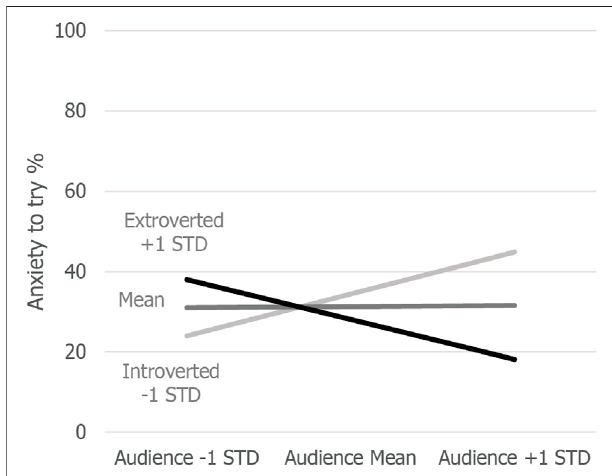
FIGURE 11 | Simple slopes equations plot (Hayes, 2017) at three levels of Audience and Extroversion predicting Anxiety levels, after controlling for Age and VR